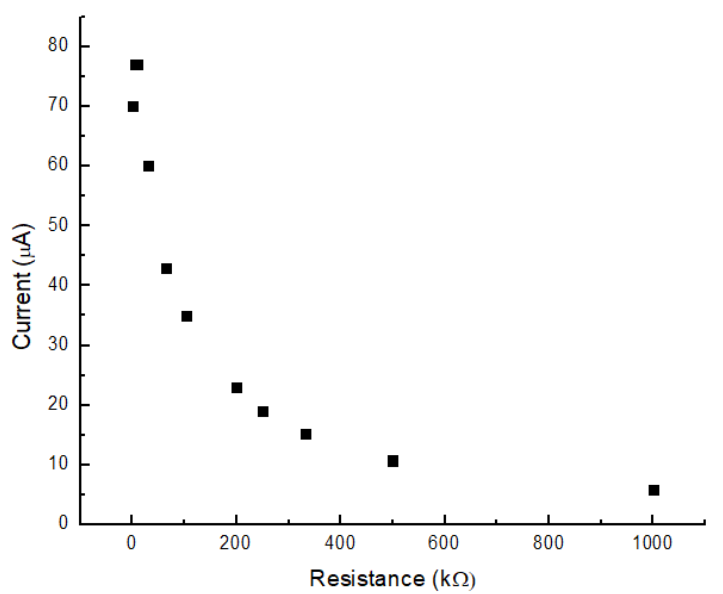
Figure 8. BERS current output while connected to different external